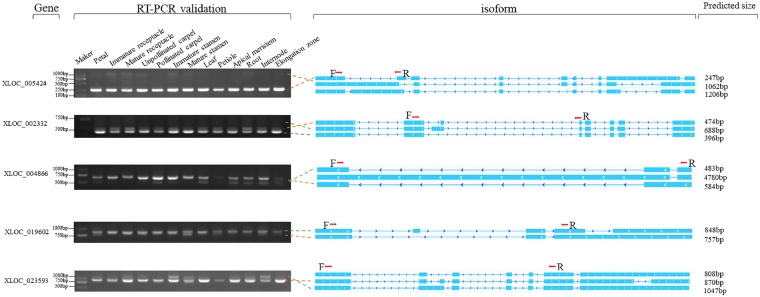
RT-PCR validation of AS events for five genes. Gel bands in each image show DNA makers and PCR results in 13 different samples. Predicted structure of each isoform is shown in right panel. Boxes and line with arrows show exons and introns, respectively. The predicted size of each full length is shown at the end of each line. The loci of PCR primers (F, forward and R, reverse) are shown on the first isoform of each gene.